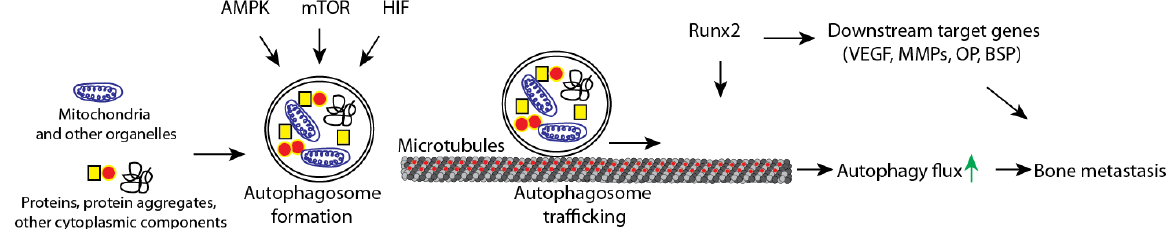
Figure 2. Autophagy is positively regulated by AMPK and HIF signaling pathways with the mTOR pathway serving as a negative regulator. Upon induction of autophagy damaged organelles and macromolecules are engulfed in a double membrane vesicle known as an autophagosome. Autophagosomes traffic along microtubules towards the lysosome to allow for fusion and enzymatic degradation of autophagosomes and their contents into macromolecular subunits (flux). Runx2 serves a dual role in promoting metastasis, (1) through the enhancement of microtubule acetylation and autophagosome trafficking, and (2) providing transcriptional support and upregulating genes implicated in bone metastasis such as VEGEF, assorted MMP’s, osteopontin (OPN), and bone sialoprotein (BSP), among others.